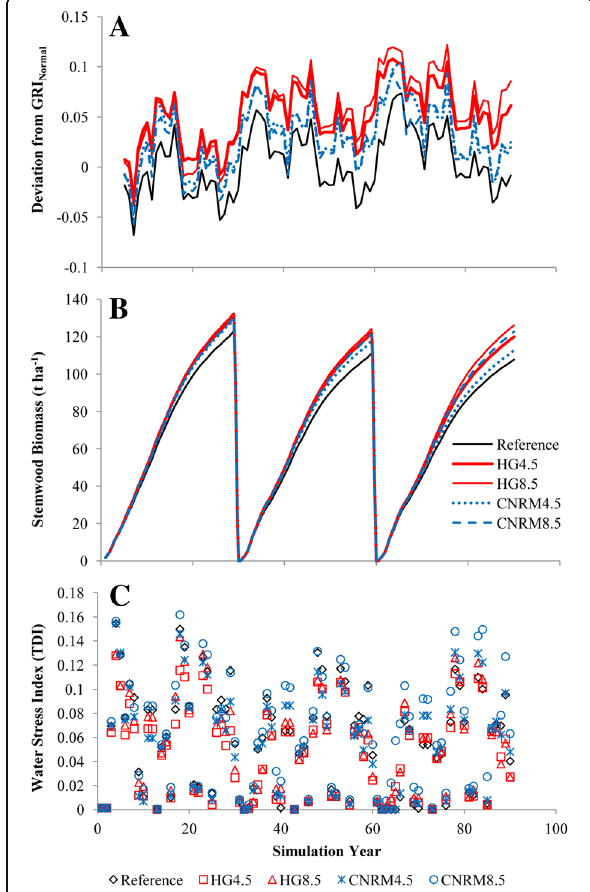
Fig. 7 Simulation results showing the impacts of climate change on the growth of Chinese fir. a The relative change in the annual growth response index (GRI y ) from the climate normal (GRI Normal ), lines represent 5-year moving averages; b stemwood biomass production; and c the annual water stress index (TDI) for four climate change projections and the reference climate for Chinese fir on a medium